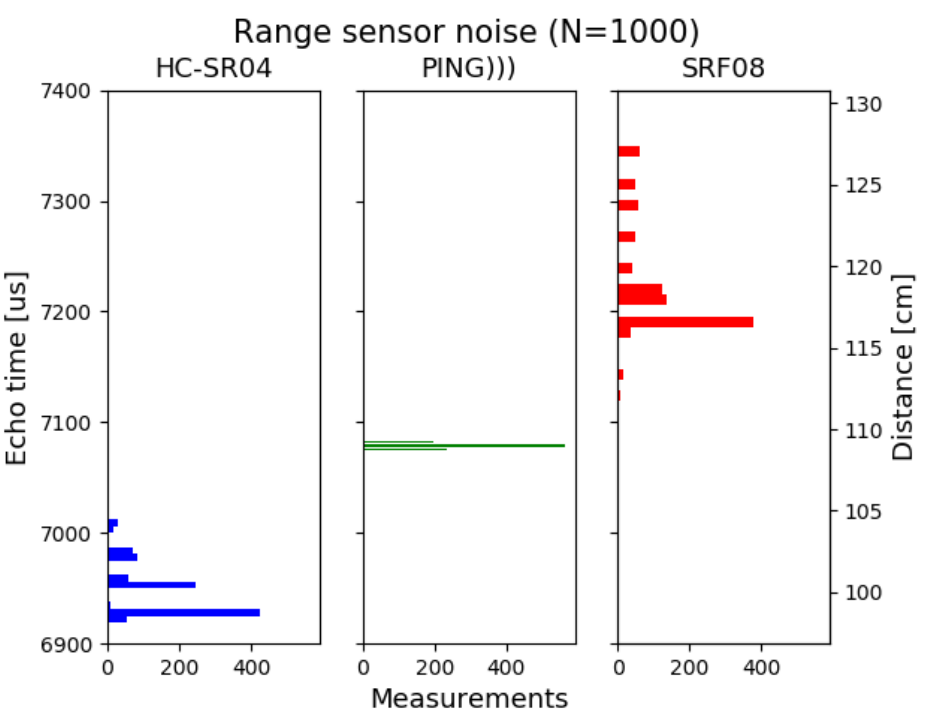
Figure 1. Measurement noise to an static obstacle with a HC-SR04 sensor, a Parallax Ping sensor and a SRF08 sensor.